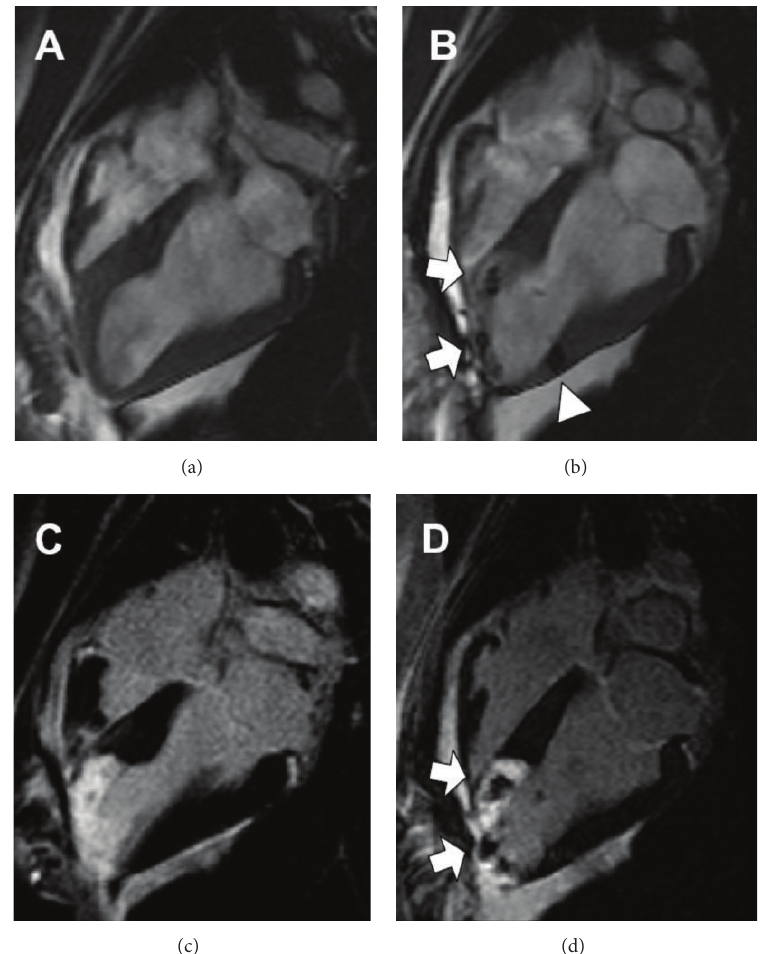
Figure 2: In vivo visualization immediately before and after IFP-MSC injection. Long-axis SSFP MRI view of left ventricle before (a) and after (b) transcatheter injection of 4 × 106 IFP-labeled MSCs into the infarct at the apex (arrows) and adjoining normal myocardium (arrowhead). DelayedenhancementMRIhighlightsareasofnonviableinfarctedmyocardiumusingthesameviewasabove,before(c)andafter(d)injection of IFP-labeled MSCs. MSCs appear dark against hyperenhanced infarct (reproduced with permission